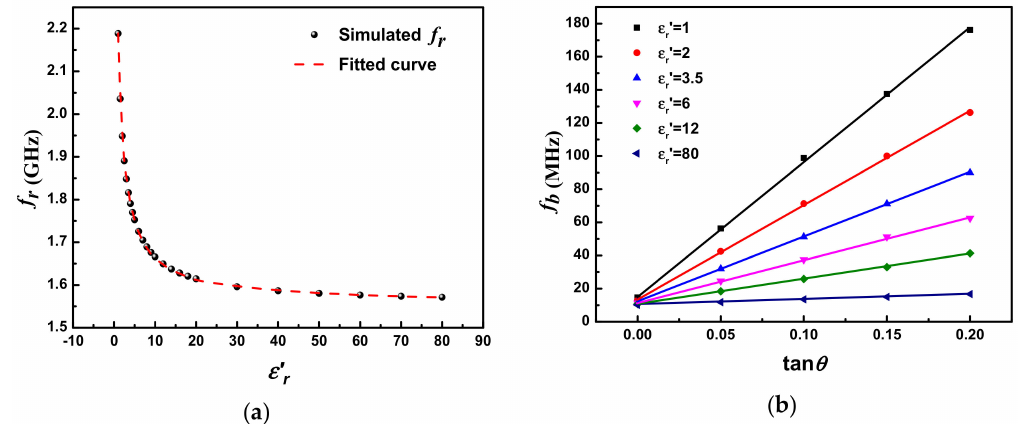
Figure 7. Simulated transmission response of the designed sensor with respect to the permittivity ε (cid:48) r and tan θ of LUT.